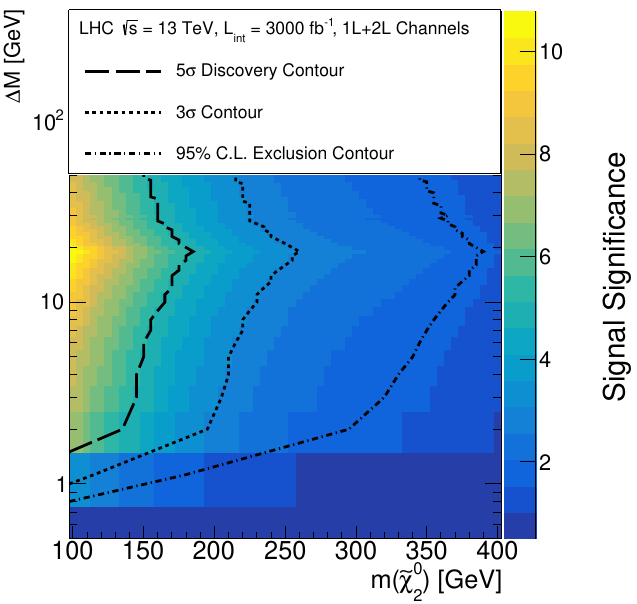
Figure 11 . Combined signal significance for the dilepton final states as function of ˜ χ 0 different integrated luminosity scenarios.